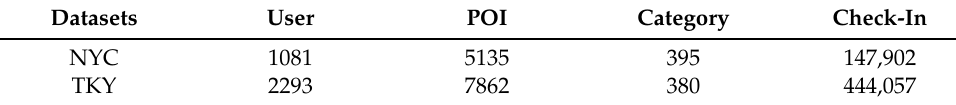
Table 1. Statistics of the evaluation